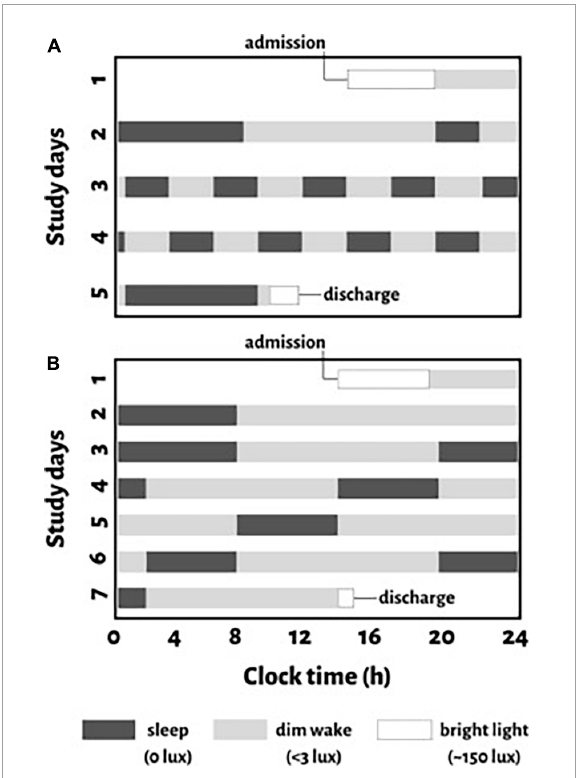
FIGURE1 Schematic representation of study protocols for an individual with a habitual sleep time from midnight to 8:00 a.m. (clock time is provided on the x -axis). For protocol 1, (A) a baseline night of sleep at this habitual time is followed by a baseline day of wakefulness (11-hours). After baseline assessments, the circadian protocol is introduced which evenly distributes behaviors across all circadian phases with 10 identical consecutively recurring 5-hour 20-minute cycles (2-hour and 40-minute of scheduled wakefulness and 2-hour and 40-minute of a scheduled sleep opportunity) across 5 days. For protocol 2, (B) two nights of sleep at the participant’s habitual sleep time with 16-hour scheduled wakefulness in between, is followed by a circadian protocol with reoccurring 18-hour “days” (12-hour wake and 6-hour sleep cycles) across 7 days. Black boxes indicate scheduled sleep opportunities in darkness ( < 0.1 lux), gray bars indicate scheduled wakefulness in dim light ( ∼ 3 lux), and white boxes represent regular room light used when participants are admitted or discharged from the